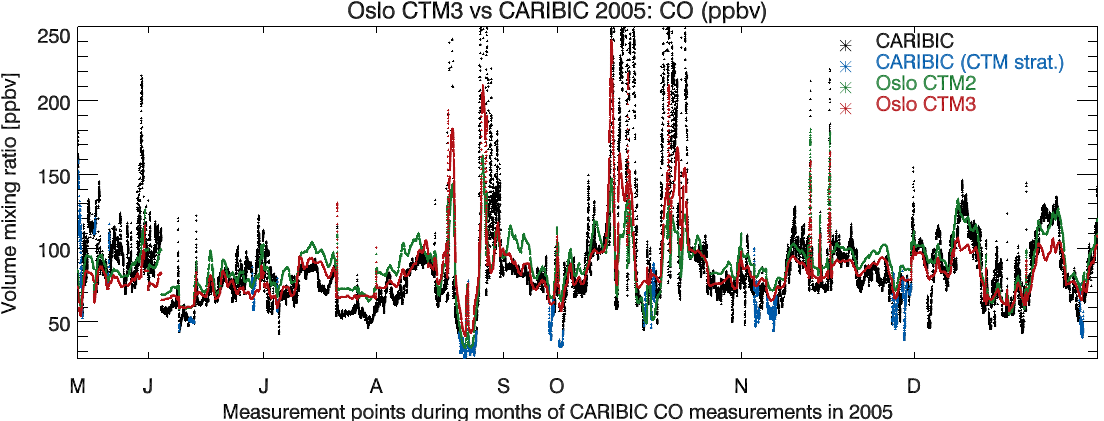
Fig. 11. Oslo CTM3 (red) and CTM2 (green) compared with all CO measurements from CARIBIC flights (black) in 2005, resulting in an asynchronous time axis where only the start of each month is shown. Measurements carried out at locations in the CTM stratosphere (defined by 2.5PVU) are shown in the blue “CARIBIC (CTM strat.)”